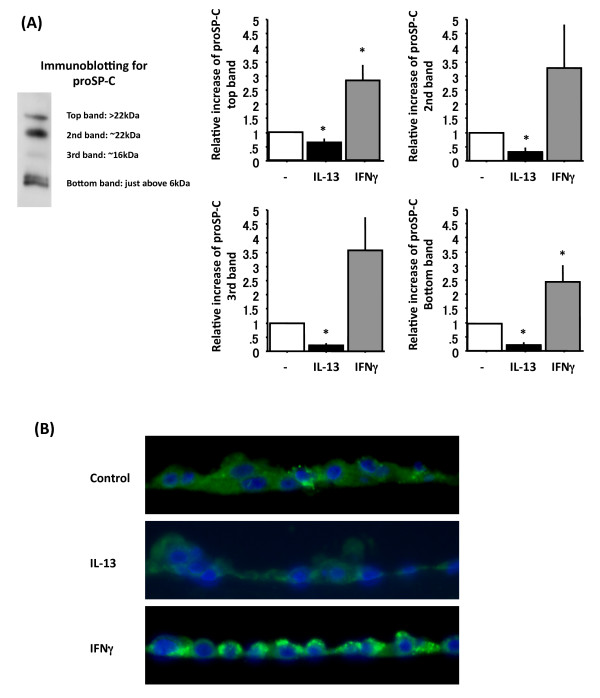
IFN-γ increases whereas IL-13 decreases proSP-C. Adult human ATII cells were cultured on Matrigel and rat-tail collagen coated inserts in DMEM containing 5% heat inactivated human serum for 2 d with10 ng/ml TGFα followed by 4 d 10 ng/ml KGF with or without 4 d 20 ng/ml IL-13 or 100 ng/ml IFN-γ. Panel A shows protein levels by immunoblotting for four different proSP-C bands normalized by GAPDH from 6 different donors cells stimulated by 4 d 20 ng/ml IL-13 or 100 ng/ml IFN-γ, which are analyzed by NIH Image. Representative protein levels by immunoblotting are shown on Figure 1 Panel B lane 3, 5 and 7. White bar: without IL-13 and IFN-γ, black bar: with 20 ng/ml IL-13 for 4 d, grey bar: with 100ng/ml IFN-γ for 4 d. *: p < 0.05 v.s without IL-13 or IFN-γ. Panel B shows immunocytochemistry for proSP-C. Top picture: without IL-13 or IFN-γ, middle one: with IL-13, bottom one: with IFN-γ. green: proSP-C, blue: DAPI. These three pictures were taken at the same exposure times.